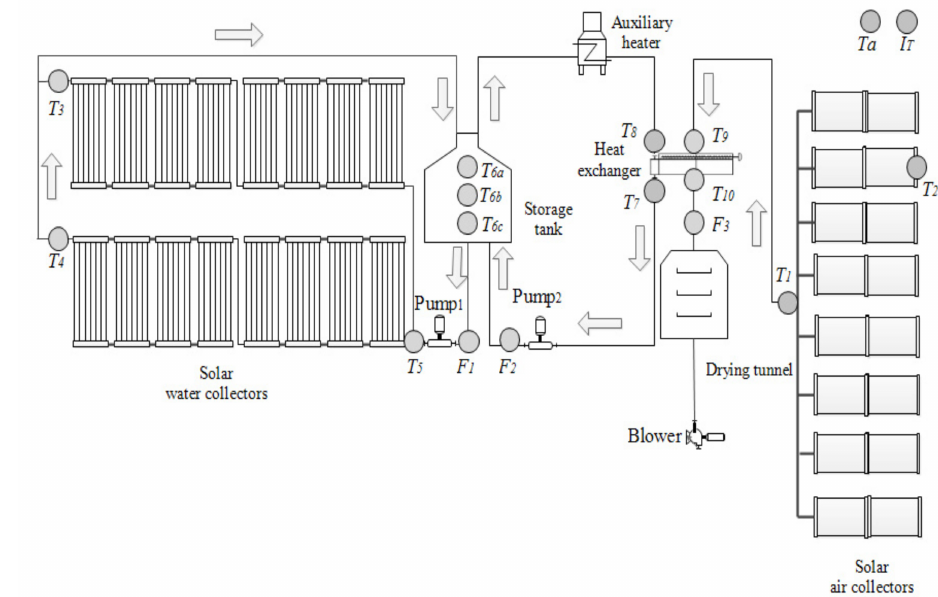
Figure 3. Solar air heating system